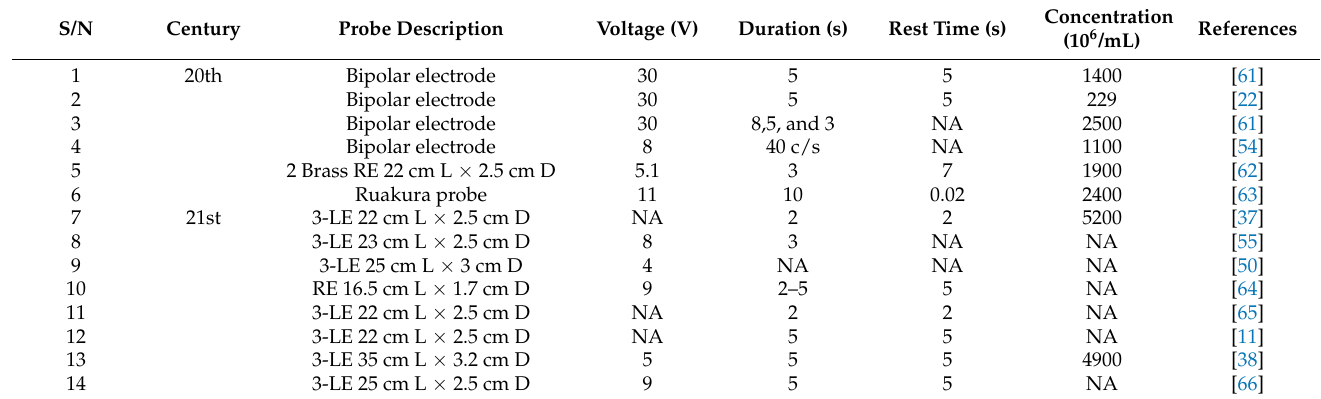
Table 1. Electroejaculation probe types and voltages used in different